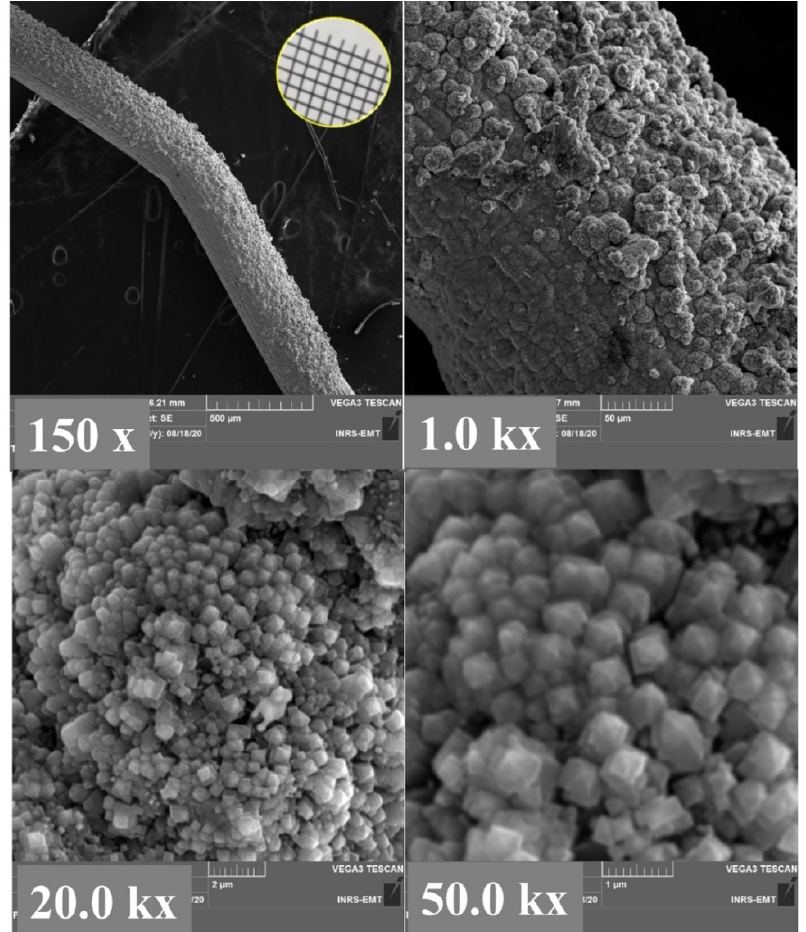
Figure 5. SEM micrographs at increasing magnifications of Pt grown by PLD on a TiO 2 /Ti mesh structure. Inset at the top left of the figure is a photograph of Pt/TiO 2 /Ti mesh.